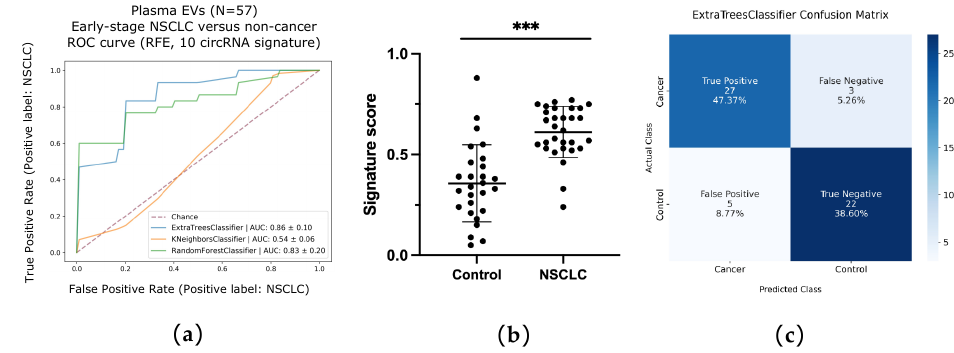
Figure 8. Machine learning (ML) analysis of extracellular vesicle (EV)-enriched samples. ( a ) Area under the ROC curve of the 10 circRNA-signature using recursive feature elimination (RFE) for cohort classification; ( b ) Scores of early-stage NSCLC versus control samples based on expression of the 10-circRNA signature ( p < 0.001 in a two-tailed Mann–Whitney U test); ( c ) Confusion matrix based on the ETC classification scores. ***: p < 0.001. Table 3. Precision assessment of the ML generated circRNA signature with ETC, RF and KNN. The 95% CI are indicated.